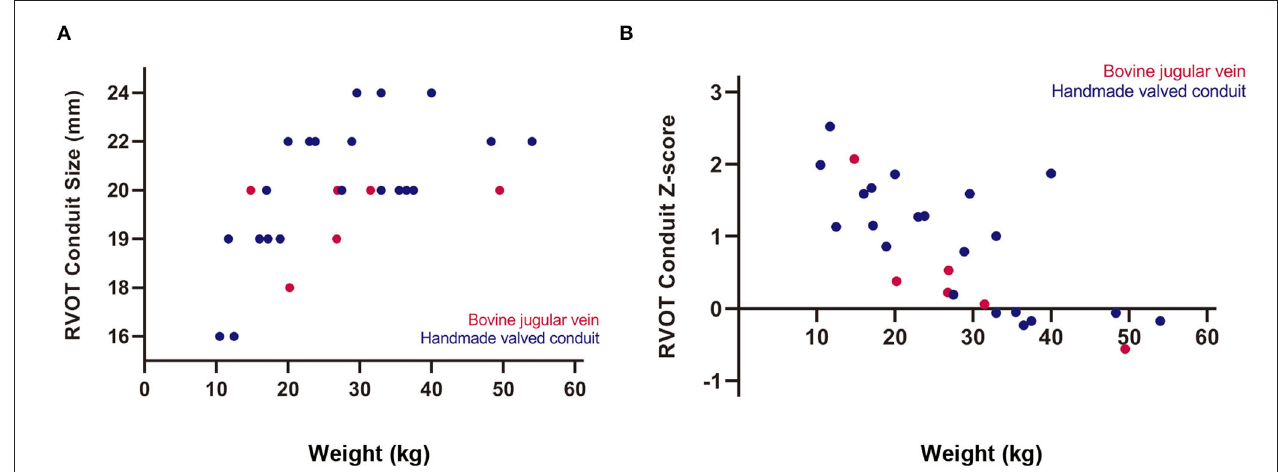
FIGURE 2 | Relationships of body weight at surgery with (A) right ventricular outflow tract (RVOT) conduit size and (B) conduit Z -score.